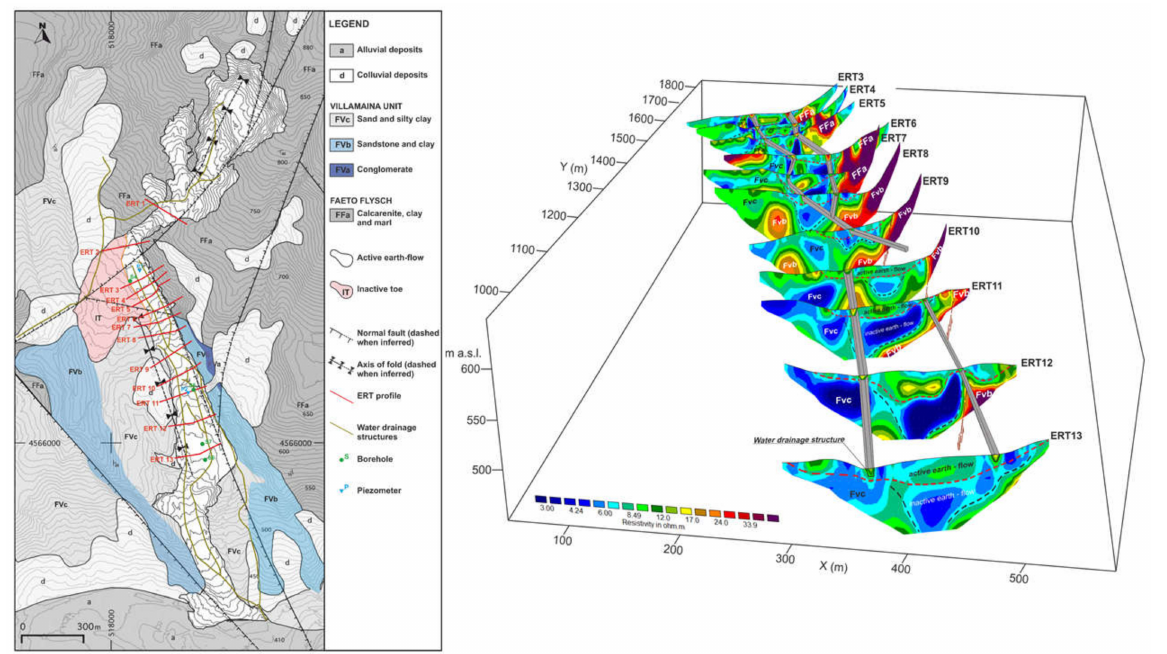
Figure 2. ( Left ) Geological map of the Montaguto earth-flow (Campania region, southern Italy) with the location of direct and indirect investigations. Red lines: ERT profiles. Green line: water drainage structures. Green dot: borehole. Blue triangle: piezometers. ( Right ) Fence diagram showing the locations of the 2D ERT (ERT 3–ERT 13) within a 3D space (after